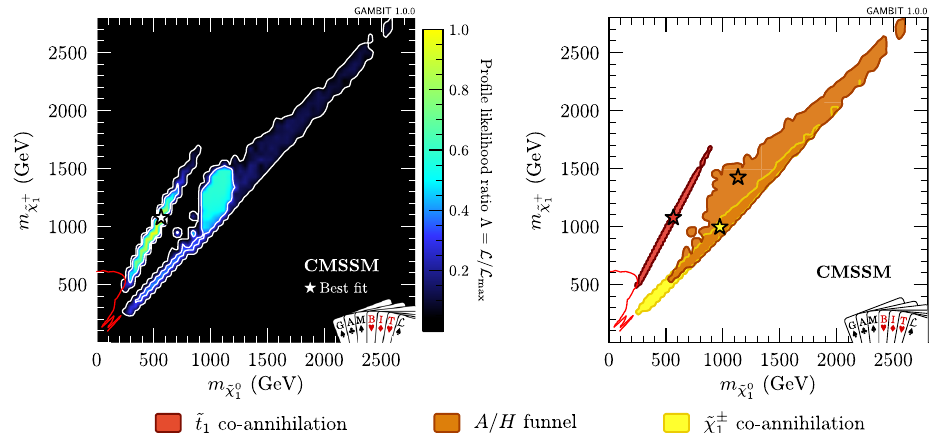
− ˜ χ 0 ˜ χ 0 mass pair production and decay with decoupled slep- model limit for ˜ χ ± 1 1 1 1 tons [320]. This limit should be interpreted with caution (for details see main text)